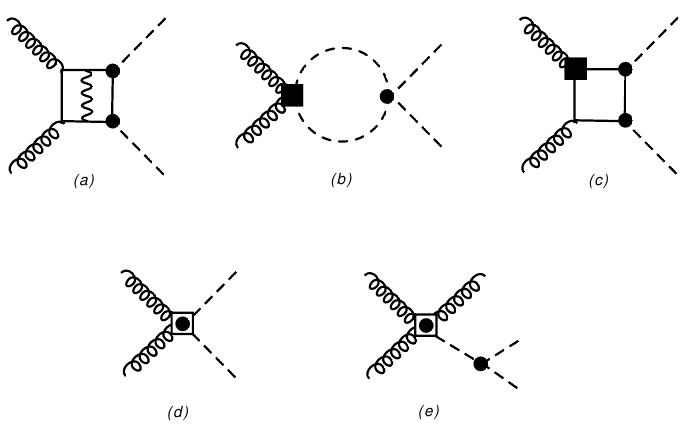
Figure 6. Higgs-pair production in gluon fusion at NLO: examples for contributions that are consistently neglected within our approximation. The dotted square indicates a local term at chiral dimension 6 (two-loop order). See text for further